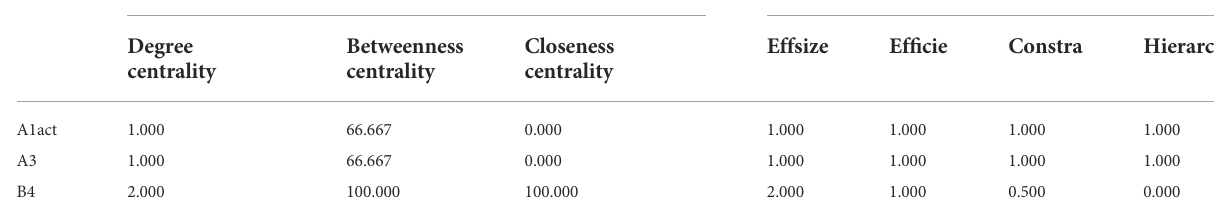
TABLE 12 Related indicators of the network after removing the key resource nodes. Node